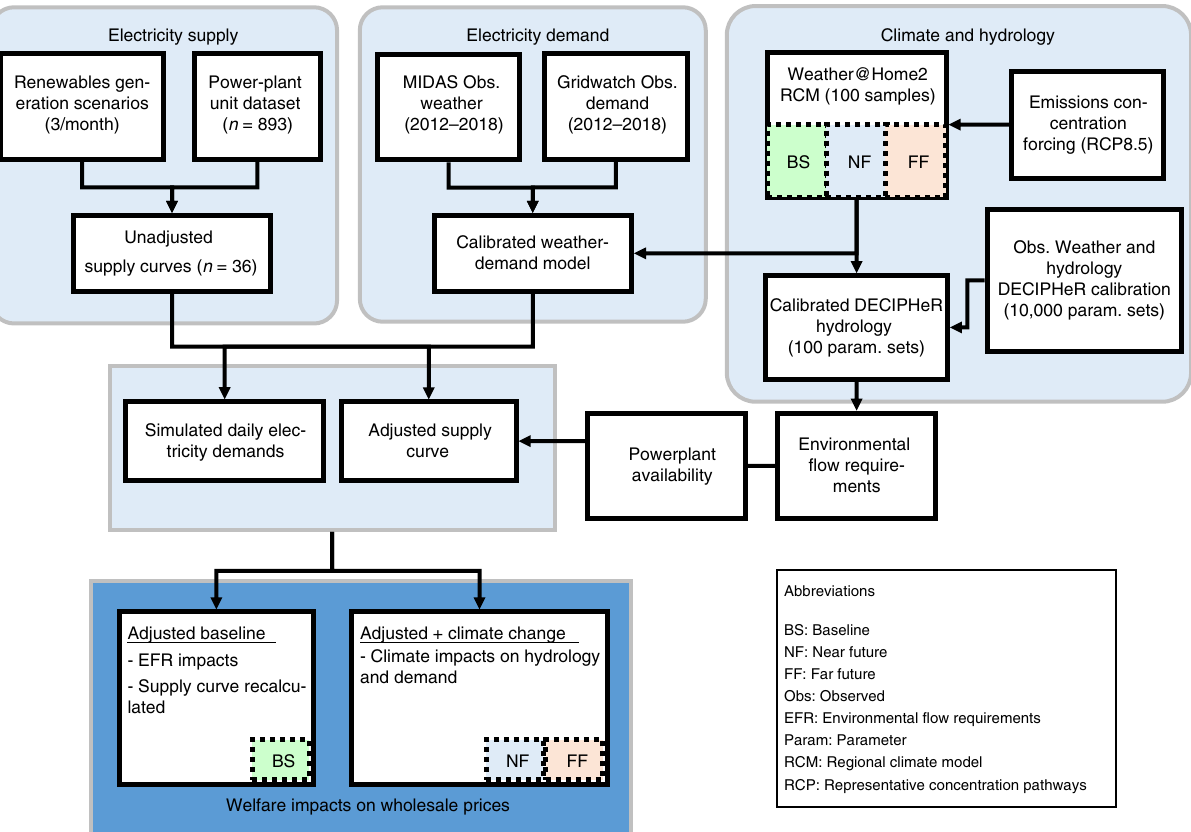
Fig. 1 Coupled hydroclimate and electricity supply – demand model framework for calculating welfare impacts of cooling water shortage for the electricity sector. Large ensemble of regional climate simulations from Weather@Home are used to simulate daily electricity demand and force the DECIPHeR hydrological model. This determines water availability at power plants taking into account environmental fl ow requirements. Plant availability is used to adjust the electricity supply curve and re-calculate the drought-adjusted electricity strike